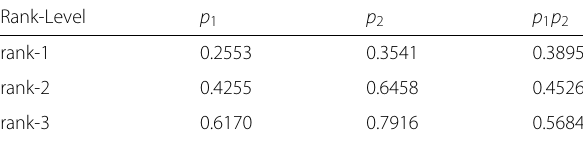
Table 8 Identification performance in the encrypted data